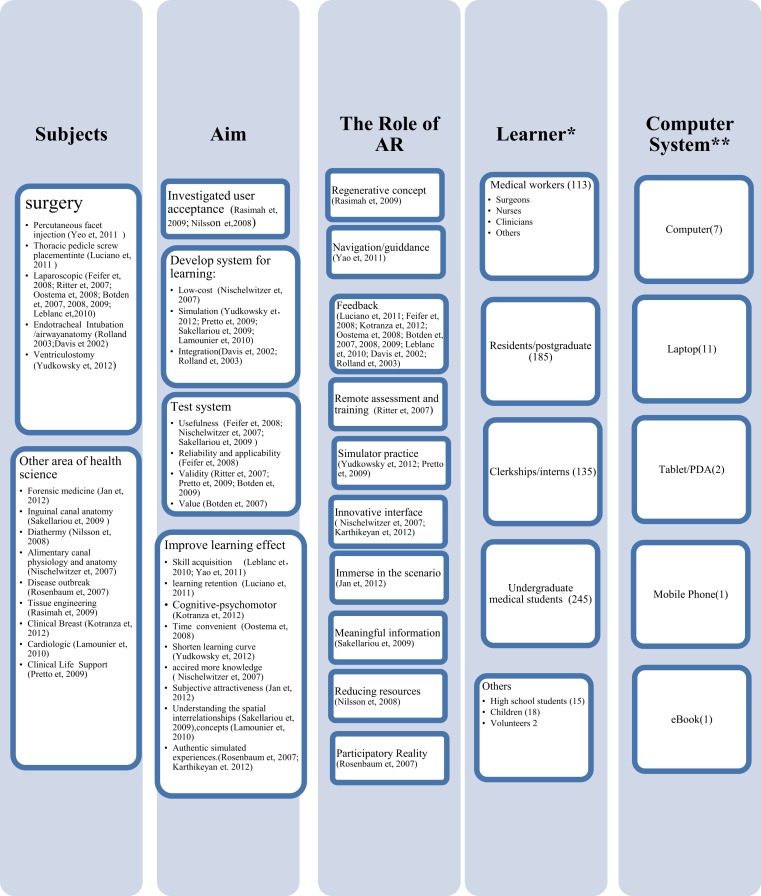
Characteristics of AR in medical education.* This number is the total of unique participants for all the included papers. We used the largest number given for two groups (Botden et al., 2007; Botden et al., 2008; Botden, Hingh & Jakimowicz, 2009a; Botden, Hingh & Jakimowicz, 2009b; Leblanc et al., 2010a; Leblanc et al., 2010b; Leblanc et al., 2010c; Leblanc et al., 2010d), who published 4 papers; ** This number shows the type of computer system that was used in the included papers. Three papers did not describe a computer system (Karthikeyan et al., 2012; Sakellariou et al., 2009; Yudkowsky et al., 2012).